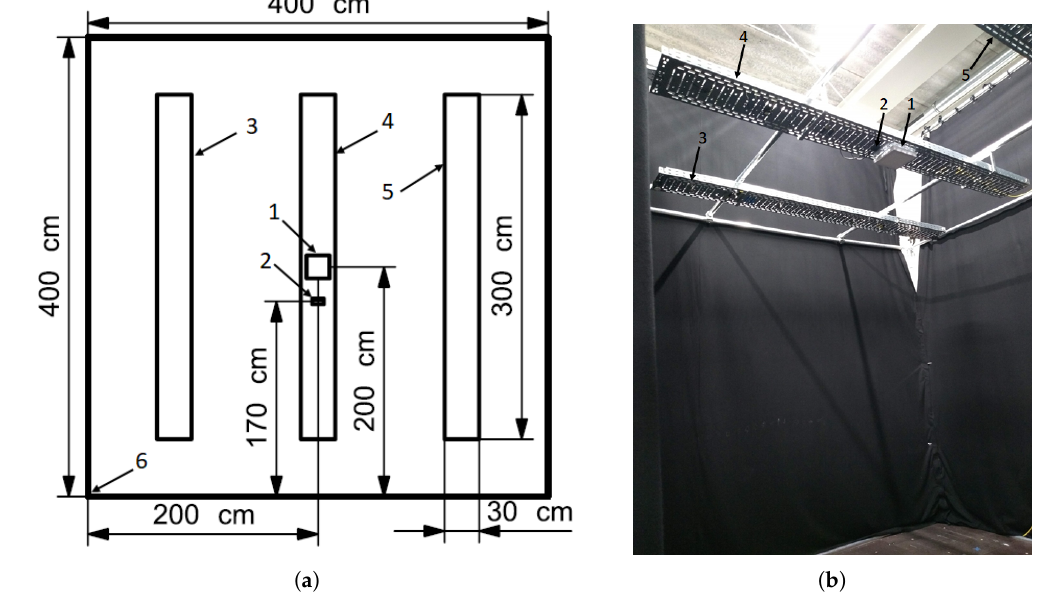
Figure 1. ( a ) The top view of the layout, ( b ) A picture of the lab with (1) the LED panel, (2) the optical receiver, (3) first rail, (4) second rail, (5) third rail, (6) the origin of the lab (location (0,0)). A simple off-the-shelf 18W 7000K floodlight LED panel (20 × 20 cm) is used as light source (Tx). The center of the LED panel corresponds with the center of the room (200,200). The used optical receiver, a photodiode (PD), is the PDA100A2 from Thorlabs [18]. The center of the PD (Rx) is